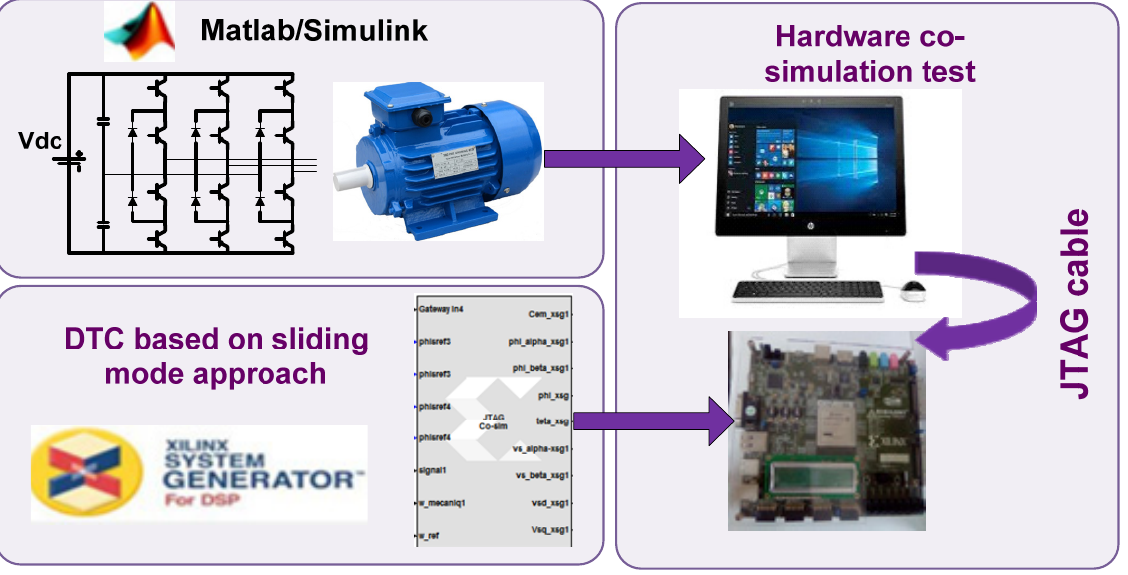
Figure 11. Synoptic diagram of co-simulation test.